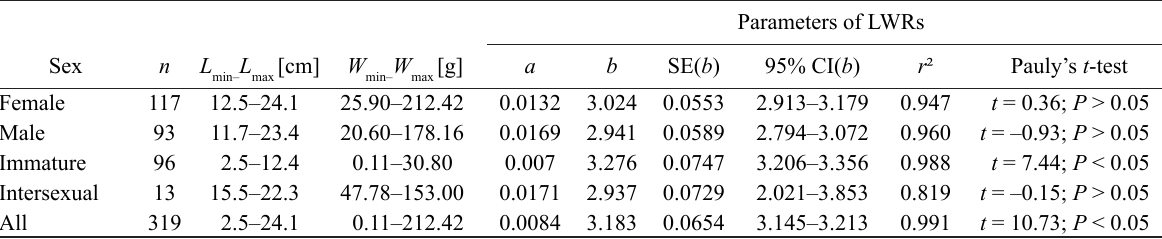
Parameters of length-weight relation for female, male, immature, intersexual and all sand steenbras in Köyceğiz